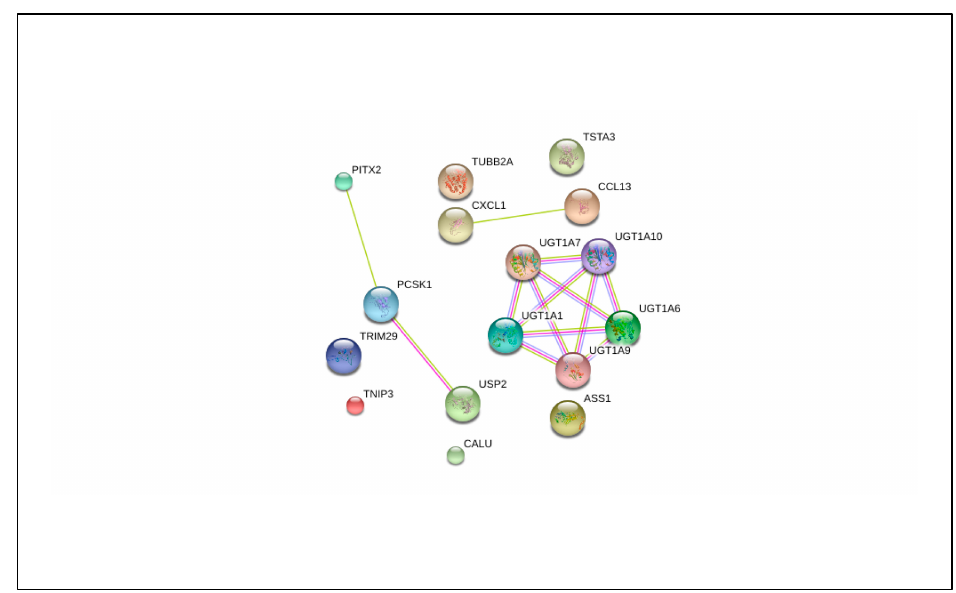
Figure 9. Predicted protein–protein interactions using the STRING database for the IBD GRN genes. Edges represent interactions between proteins, and multiple edges represent additional sources of evidence. Analysis was performed with String v. 10.